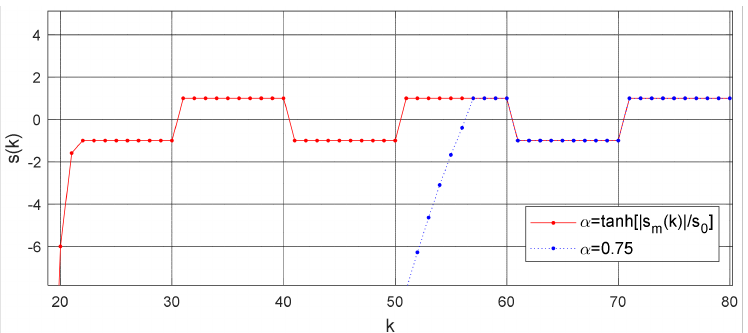
Figure 4. Sliding variable of the system for α ( k ) = tanh[| s m ( k )|/ s 0 ] and α = 0.75.